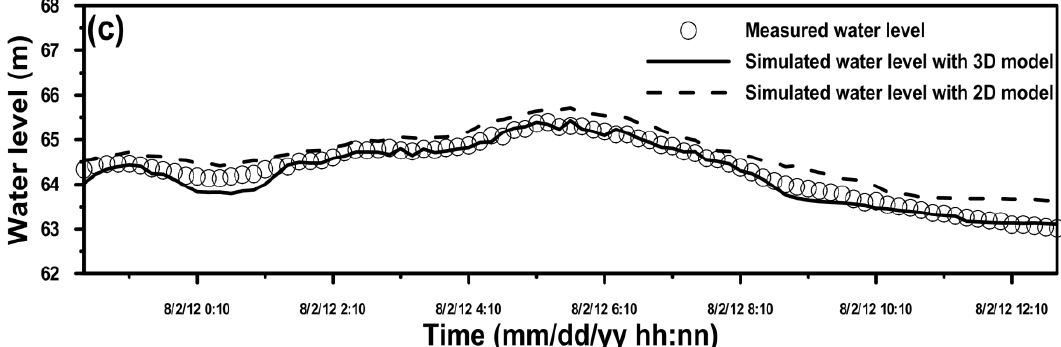
Figure 4. Comparison of performance for predicting water levels using two-dimensional and three-dimensional hydrodynamic models for ( a ) Typhoon Sinlaku (2008); ( b ) Typhoon Megi (2010); and ( c ) Typhoon Saola (2012).